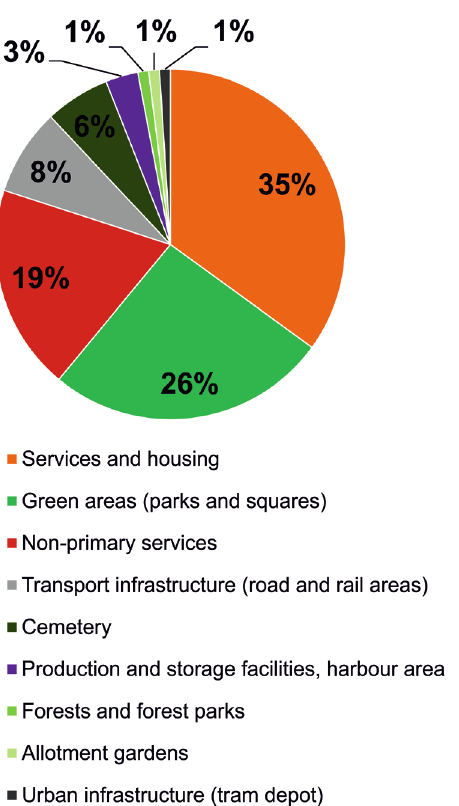
Figure 15. Planned land-use designations of the post-cemetery areas by the percentage of area covered.